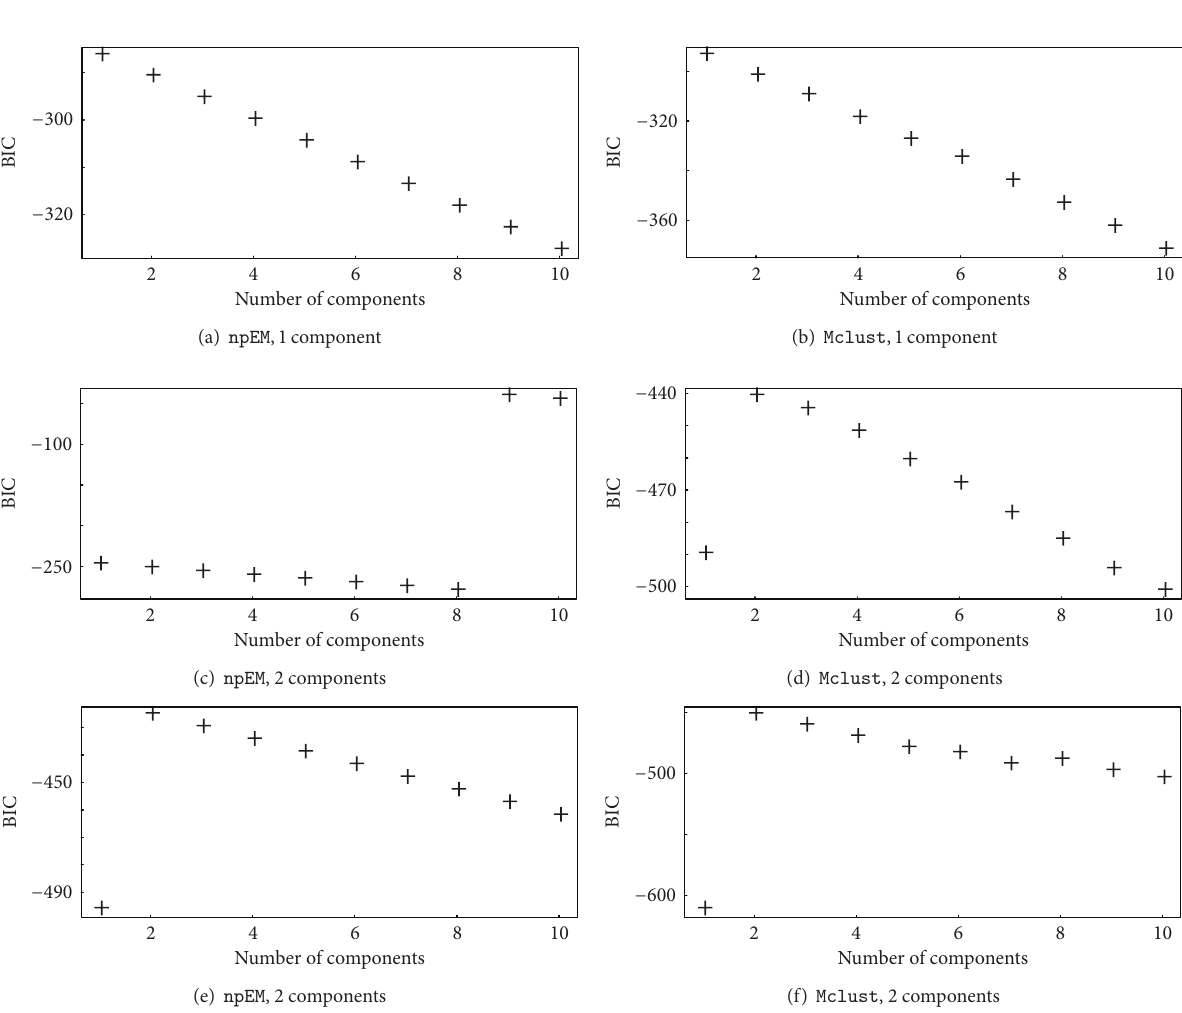
Figure 9: Comparison of npEM to Mclust for fitting: (a) single-component normal; (b) mixture of two overlapping normals as in Figure 6(b); (c) mixture of two well-separated normals as in Figure 6(a). In the application of both npEM and Mclust , the BIC is used to select the number of components, with the maximum BIC value corresponding to the chosen number of